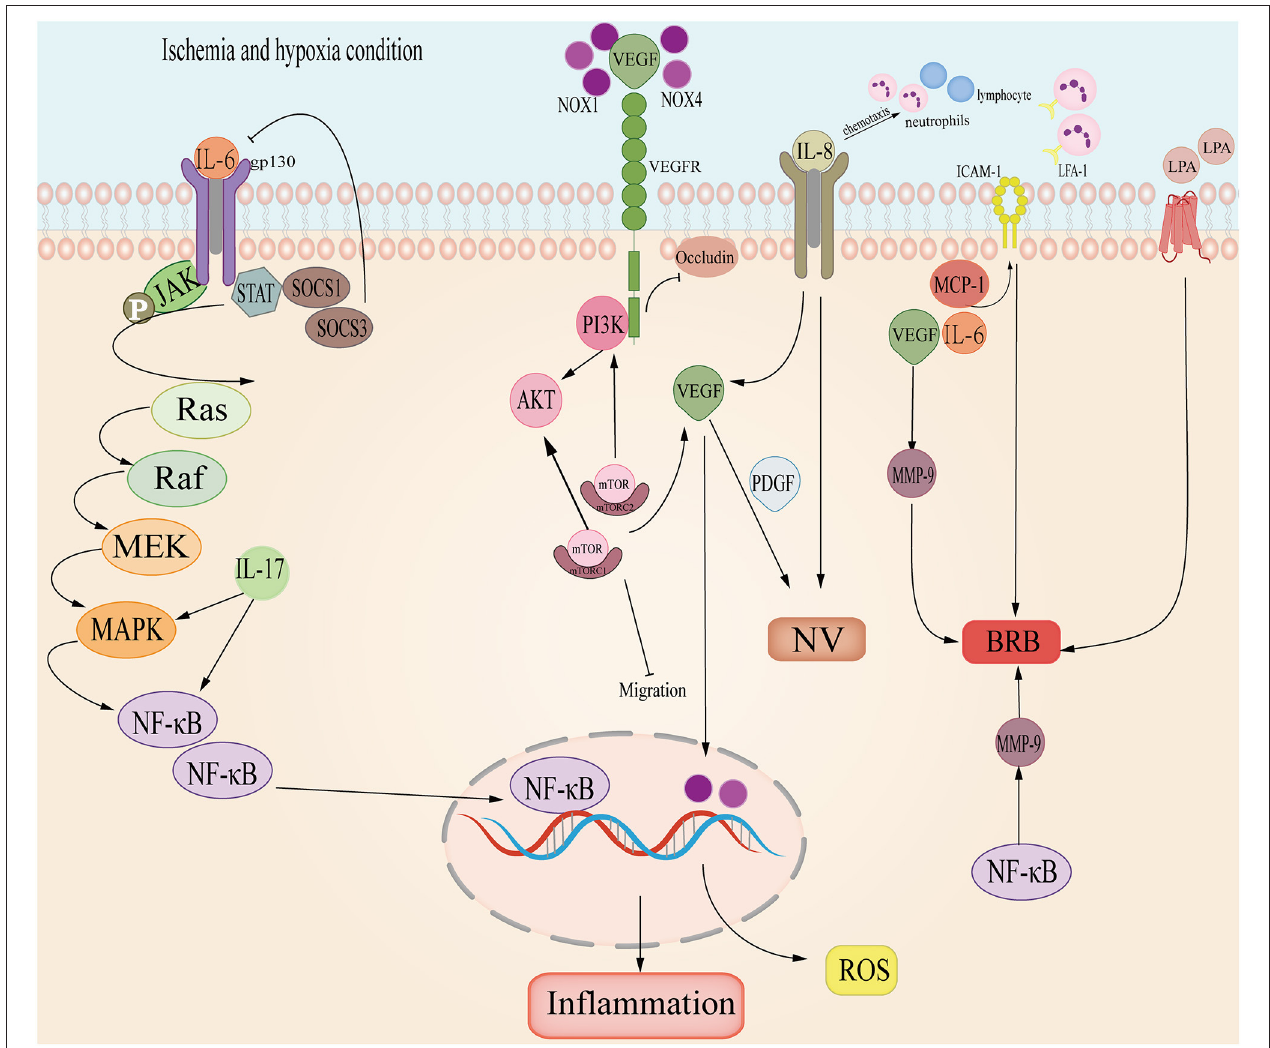
FIGURE 4 | The cytokine and chemokine pathways involved in RVO. Interleukin-6 (IL-6) promotes Janus-activated kinase/MAP kinase pathway (JAK/MAPK) and induces NF- κ B, causing retina inflammation; Interleukin-6 (IL-8) induces VEGF and leads to neovascular (NV); in ischemia and hypoxia, VEGF and PDGF promotes NV; NOX combines with VEGF, inducing PI3K/AKT and ROS; VEGF-VEGFR-2 inhibits occludin damaging the basal membrane of endothelial cells; Intercellular Adhesion Molecule-1 (ICAM-1) cooperates with VEGF, MCP-1 and IL-6 induces BRB; LPA- ATX may participate in